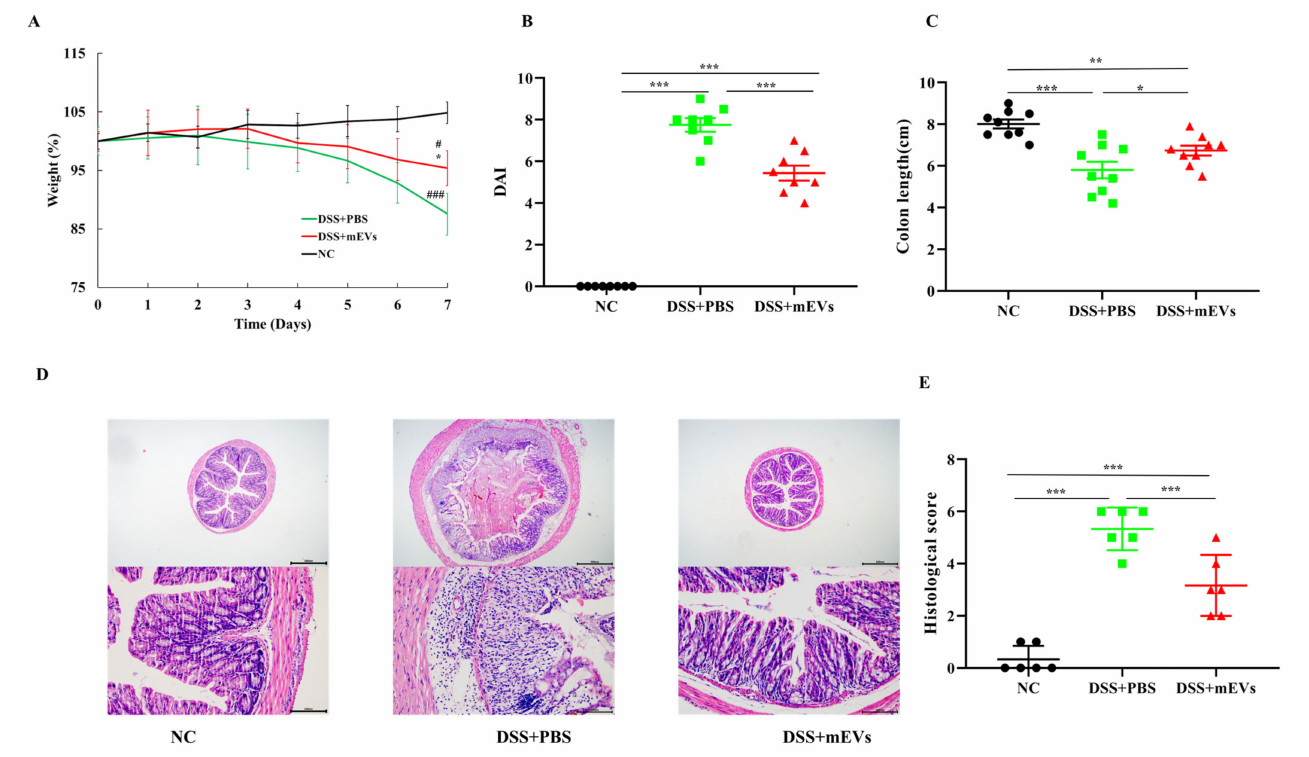
Figure 2. Oral mEVs attenuated the clinical symptoms of DSS-induced experimental colitis in mice. ( A ) Percentage of body weight change. ( B ) Disease activity index (DAI) score for colitis severity. ( C ) The length of colon tissues. ( D ) Representative pictures of hematoxylin and eosin (H&E)-stained colon sections, scale bar = 500 µ m (top) and 100 µ m (bottom). ( E ) The histology score. Data represent the mean ± SEM, n = 12 samples/group, * p < 0.05, ** p < 0.01, *** p < 0.001. * p < 0.05 relative to DSS+PBS group; # p < 0.05, ### p < 0.001 relative to NC